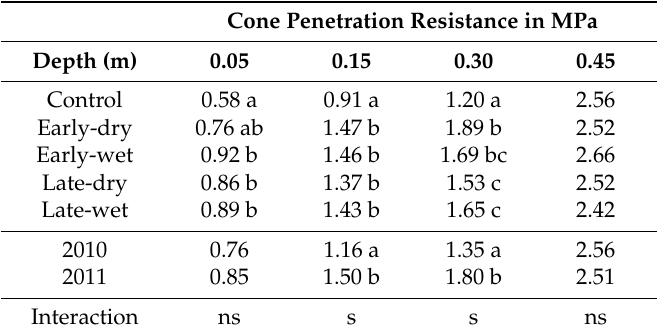
Note: Means within each column followed by the same letter are not significantly different. (s = significant; ns = non-significant).